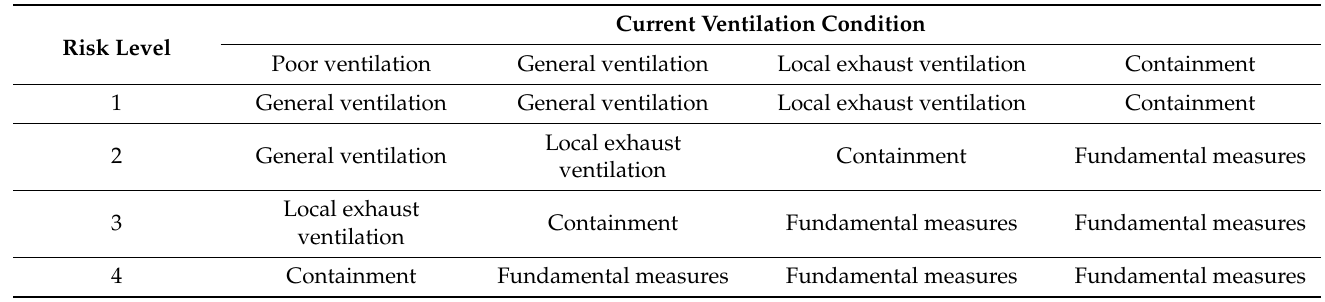
Table 7. Characterization of engineering control approach using risk levels and ventilation conditions.